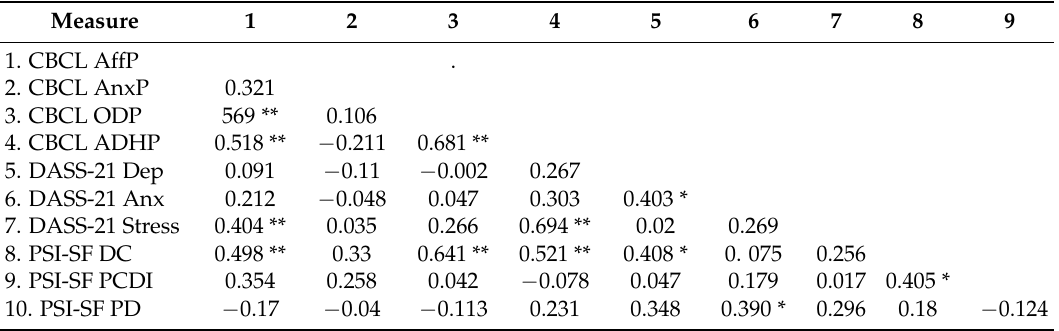
Table 3. Summary of Intercorrelations of Pre-intervention Scores on the CBCL 1 1 and